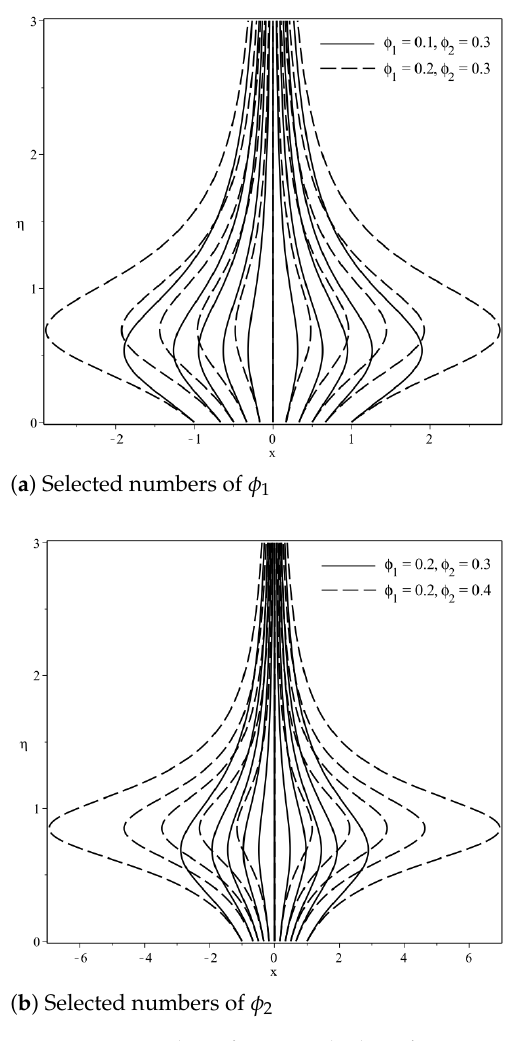
Figure 8. Streamlines for Cu and Al 2 O 3